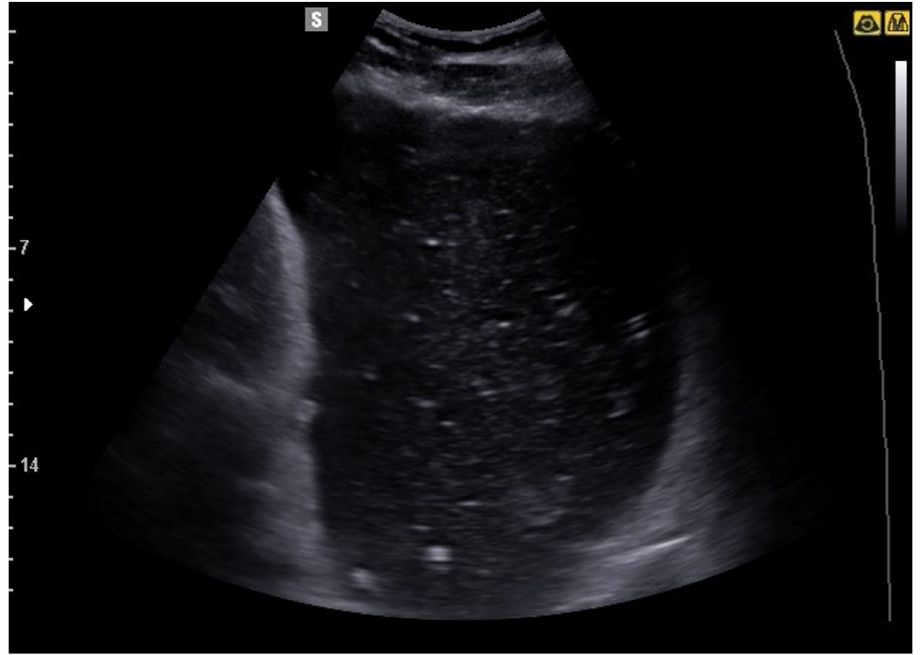
Figure 11. Image obtained with convex probe. There is an overdistension of the stomach with clear evidence of echoes inside it from ingestion. Final diagnosis of duodenal cancer with overdistention of the stomach upstream.